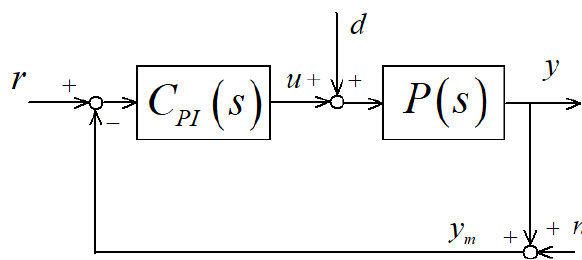
Figure 3. The block diagram of PI control.